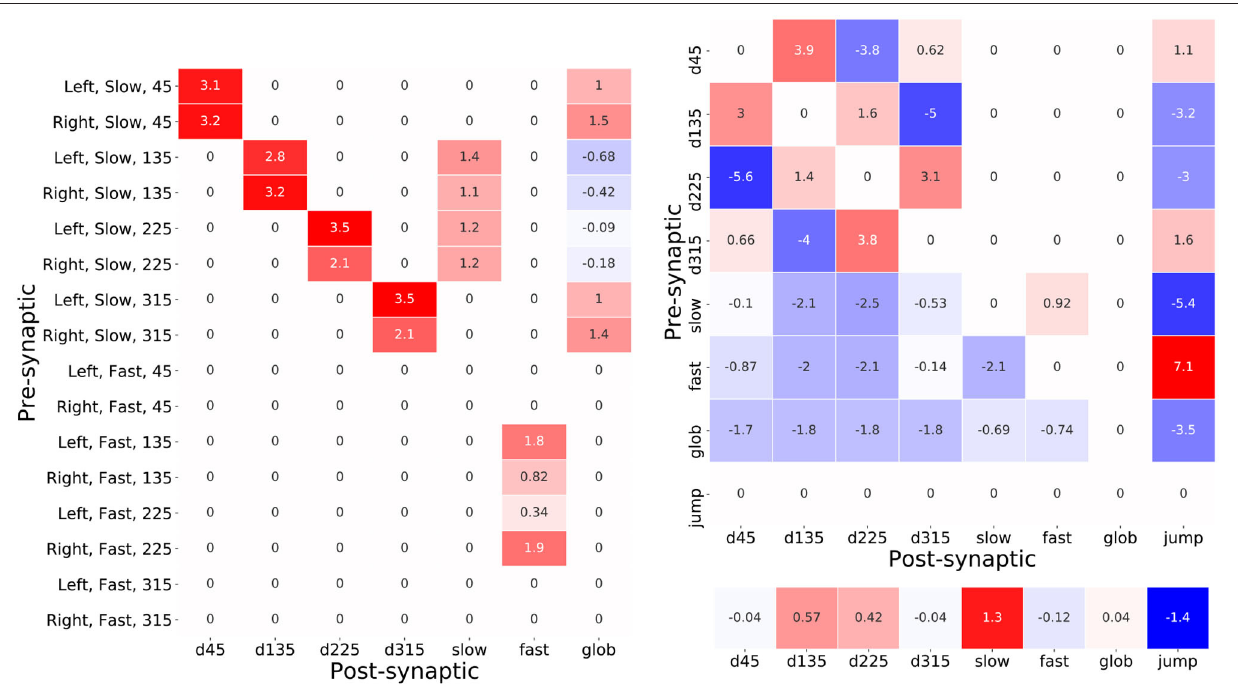
FIGURE 10 | Tables of synaptic weight parameters between pre- and post-synaptic pairs of neurons. The number in each cell shows the value of the weight and the color of the cell denotes the sign and magnitude of the weight. Red cells indicate positive weights and blue ones negative weights. (A) The table of synaptic weights between each of the sixteen input layer neurons and the seven interneurons. (B) The table of synaptic weights used for each pre- and post-synaptic interneuronal connection. The values of the interneuron biases, corresponding to their resting values, are shown below the